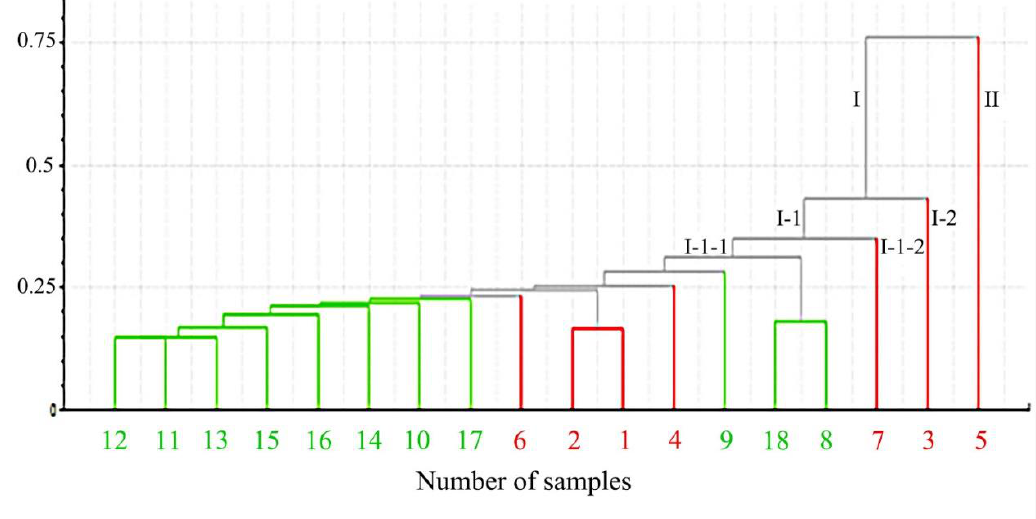
Figure 2. HCA results for 18 batches of samples.